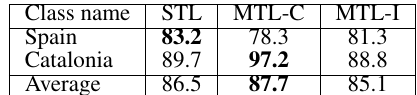
Table 8. F1-Scores [%] for the task production place (second series of experiments).